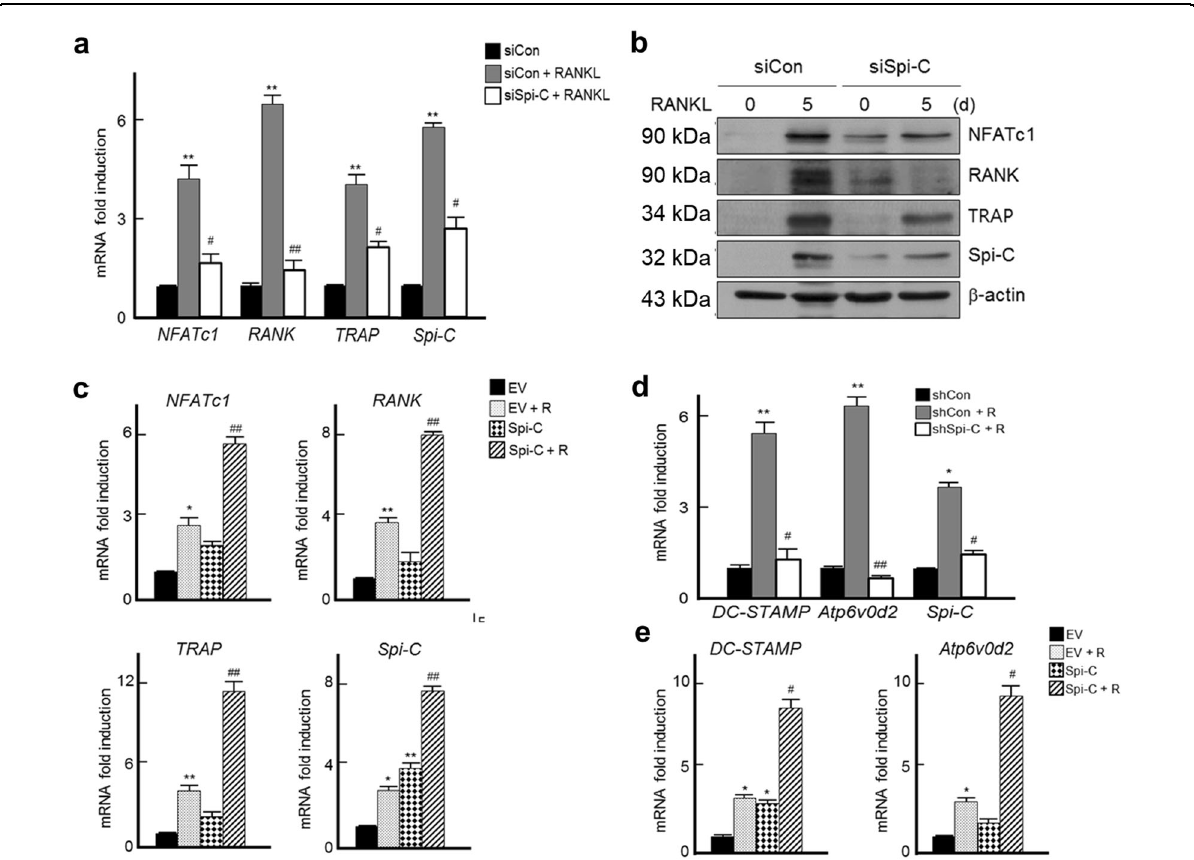
Fig. 3 Spi-C regulates osteoclast marker gene expression. a , b BMMs transfected with a scrambled nontargeting siRNA (siCon) or Spi-C siRNA (siSpi-C) were cultured without or with RANKL for 24 h a or 5 days b . Then, qPCR a or western blot analysis b was performed. c BMMs infected with an empty lentiviral vector (EV) or Spi-C-expressing lentiviral vector (Spi-C) were cultured without or with RANKL (200 ng/ml) for 24 h, and qPCR was performed. d Isolated BMMs infected with control shRNA lentiviral vector (shCon) or Spi-C shRNA expression lentiviral vector (shSpi-C) were cultured without or with RANKL (200 ng/ml) for 48 h, and qPCR was performed. e BMMs infected with empty lentiviral vector (EV) or Spi-C-expressing lentiviral vector (Spi-C) were cultured without or with RANKL (200 ng/ml) for 48 h, and qPCR was performed. The data are presented as the mean ± SD of three independent experiments. * p < 0.05, ** p < 0.005 vs. untreated cells and # p < 0.05, ## p < 0.005 vs. RANKL-treated